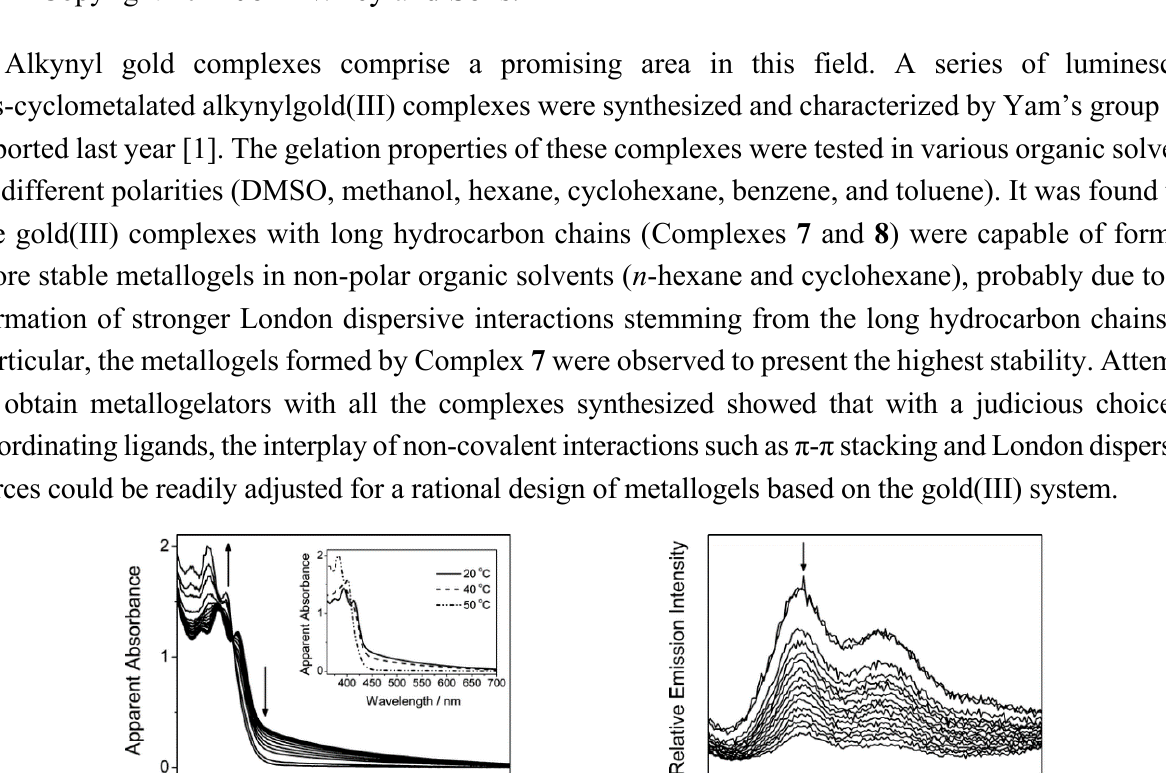
Figure 4. ( a ) TEM image, ( b ) SEM images of 6 -SP ( above ); Photographs showing formation of the viscous fluid (supramolecular polymer) of 6 in CH 3 CN. ( c ) Suspension of 6 at 298 K; ( d ) Dissolution of 6 on heating at 323 K; ( e ) Formation of viscous fluid ( 6 -SP) after cooling the solution in ( d ) to 298 K ( below ). Adapted with permission from ref. [41]. Copyright 2012 John Wiley and Sons .